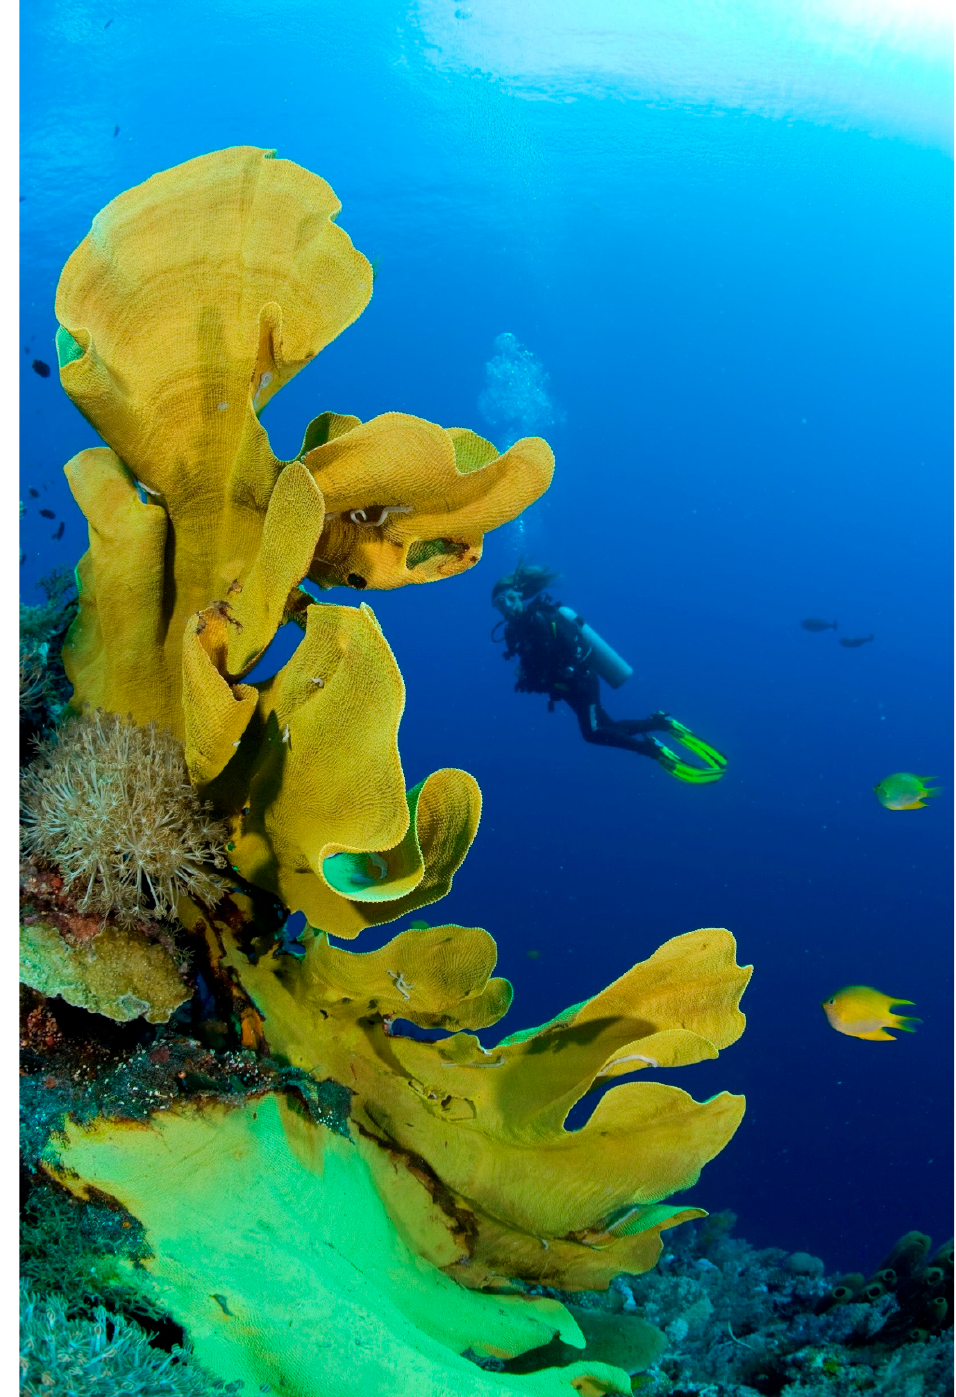
Figure 1. Marine verongiid demosponge Ianthella basta possess a huge chitin-based, a network-like skeleton that is stiff enough to withstand underwater currents due to its natural